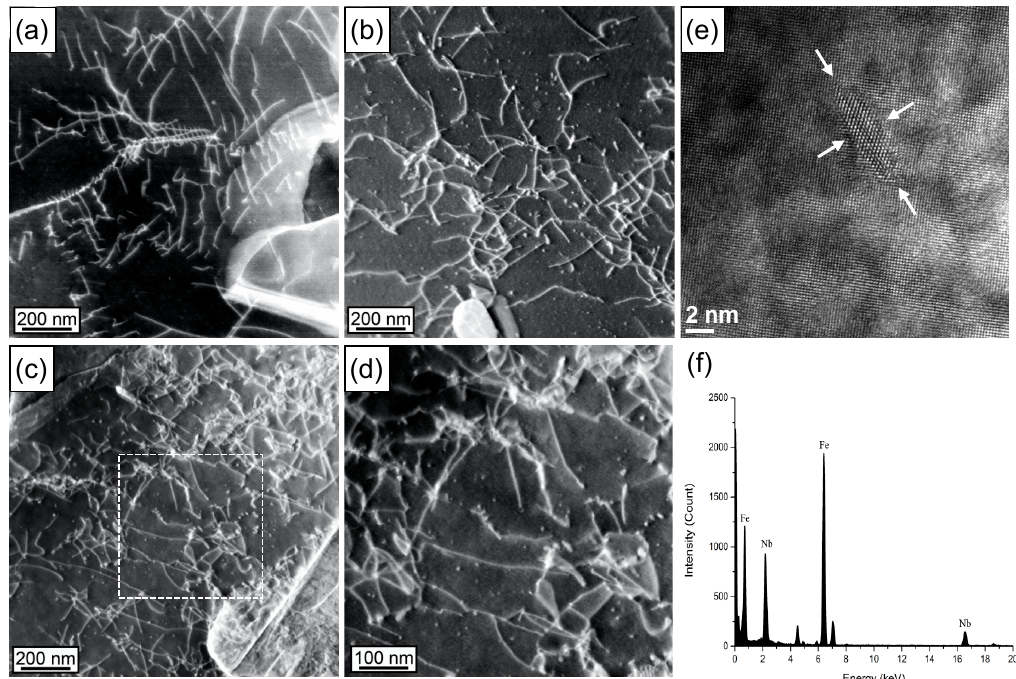
Figure 9. Evolution of niobium precipitation during processing stages characterized by TEM: ( a ) as hot rolled; ( b ) after batch annealing; ( c ) after hot dip galvanizing; ( d ) higher magnification of dashed area marked in ( c ); ( e ) representative high-resolution image of NbC precipitate in ferrite matrix after batch annealing; ( f ) EDX spectrum indicating a high level of Nb in the precipitates.